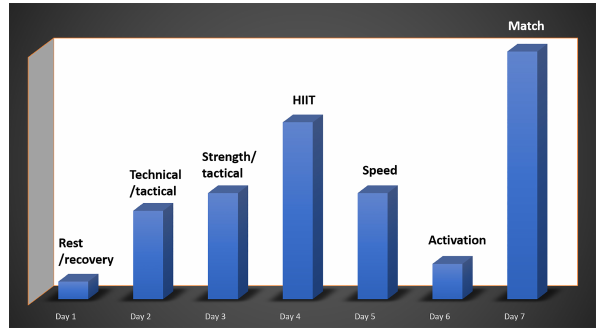
Fig. 1. The dominant training microcycle during the competi- tion season.